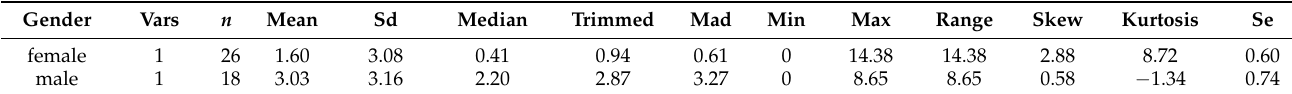
Table 6. Descriptive statistics for female and male groups.